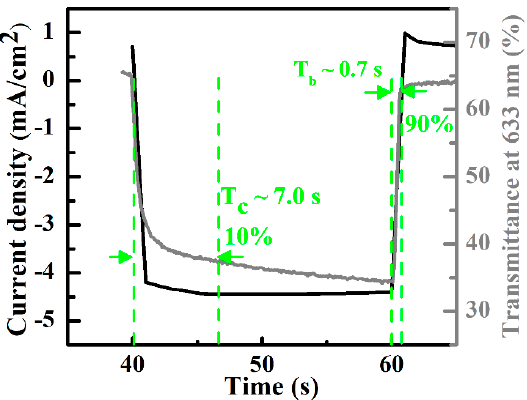
Figure 17. The response time for coloring ( T colored ) and bleaching ( T bleached ) as determined from the transmittance of the ASSECD.